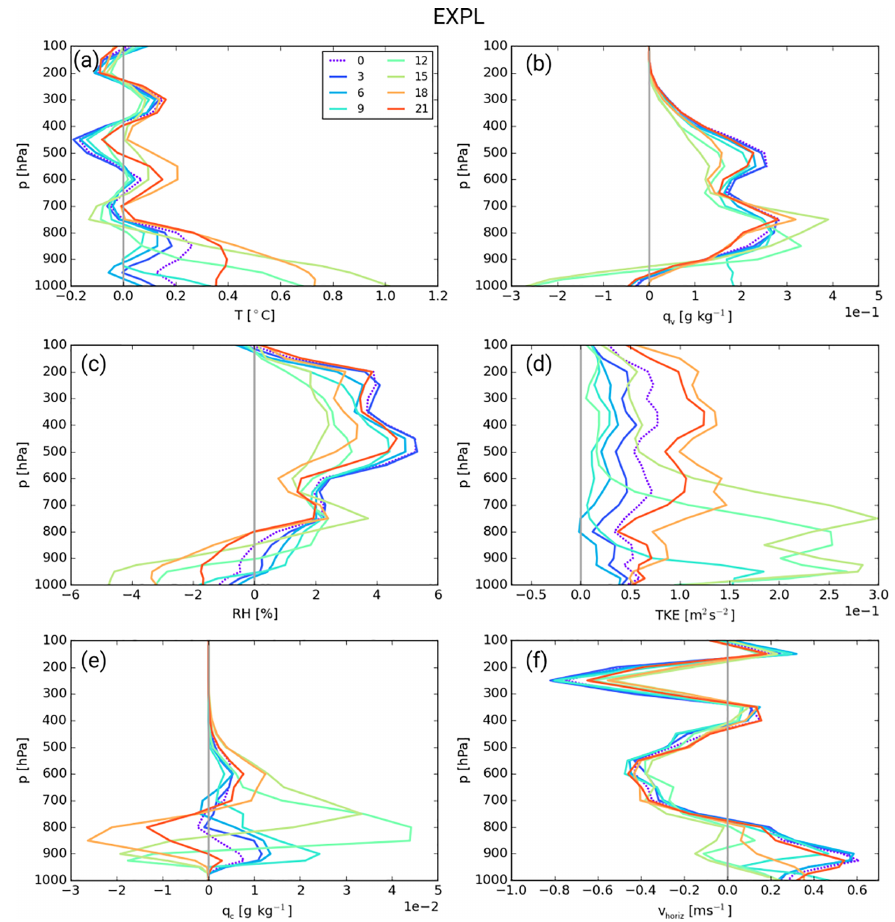
Figure 7. Diurnal cycle (coloured lines) of DACCIWA box and July 2006 averaged profiles of differences f op = 0 . 1 minus f op = 1 . 0 for EXPL showing (a) T , (b) q v , (c) RH, (d) TKE, (e) q c and (f) v horiz